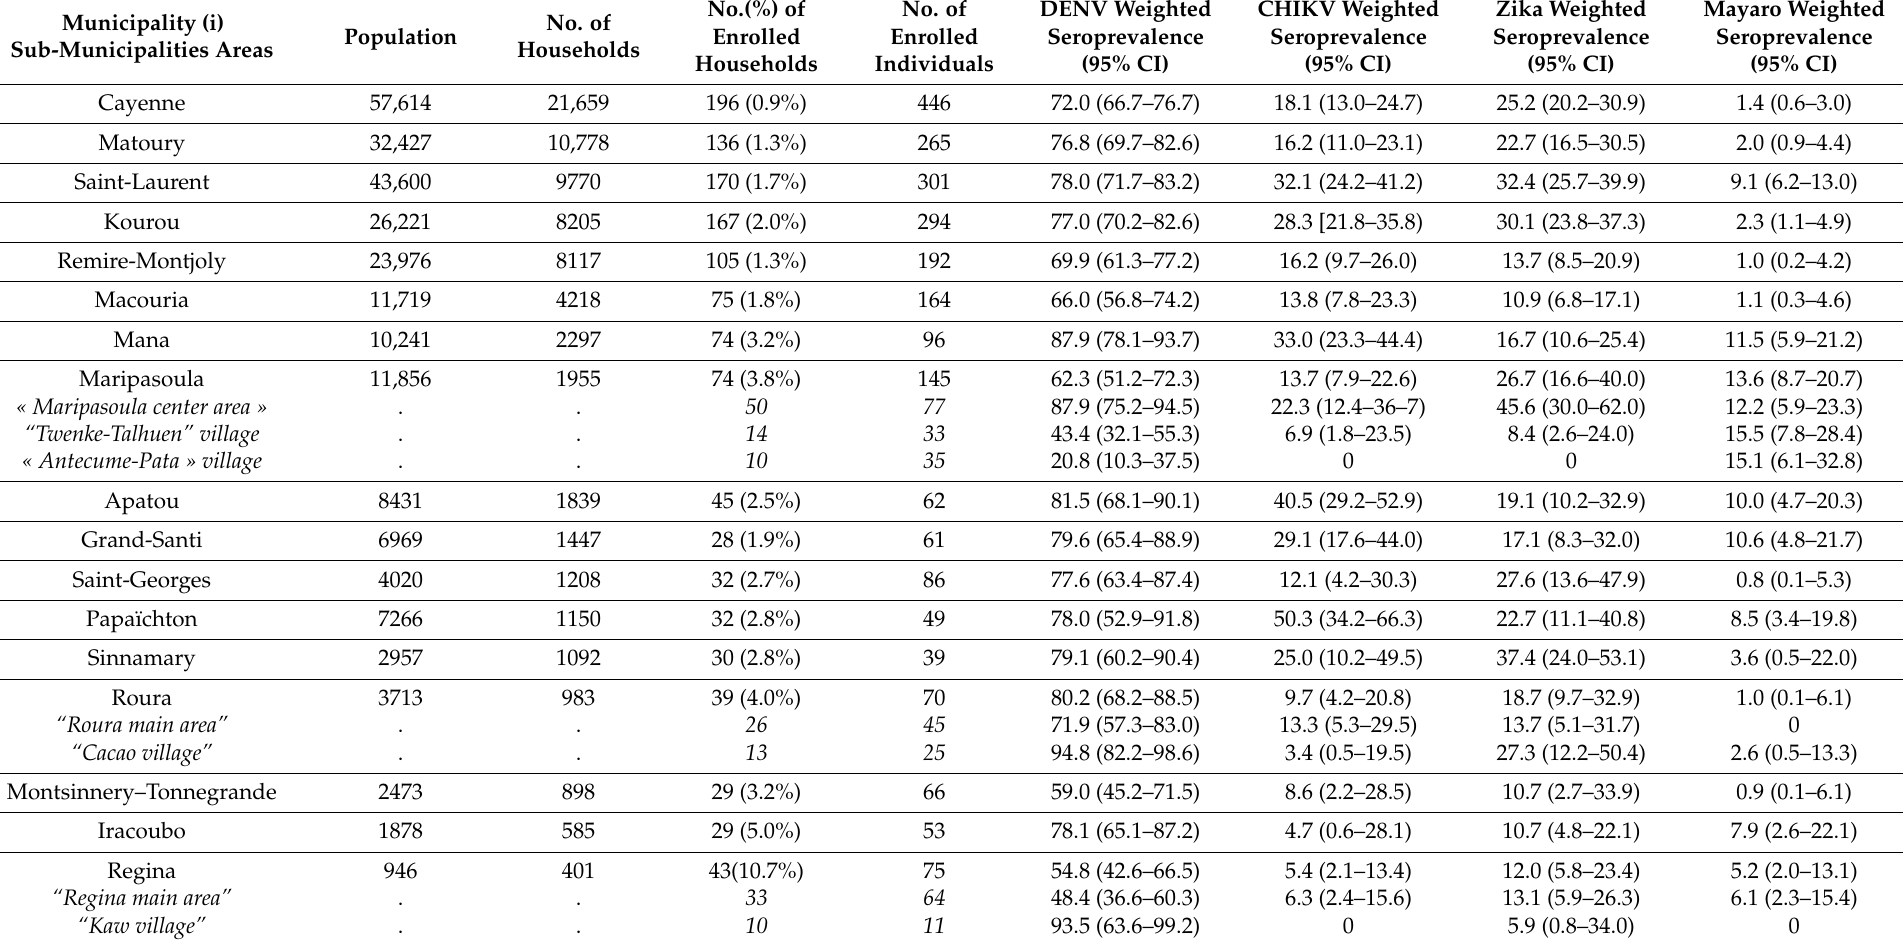
Table 1. Description of the household selection process and weighted seroprevalence estimated by